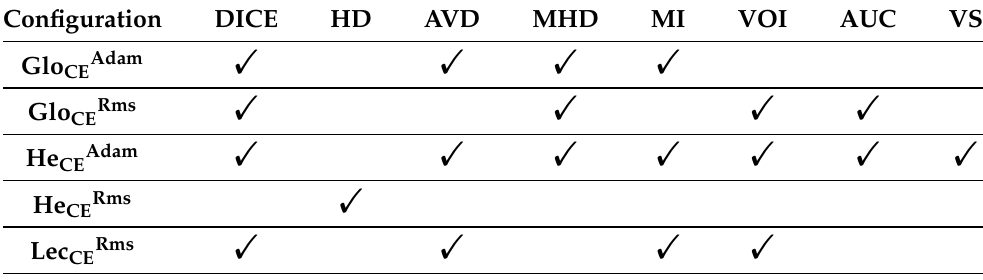
Table 6. Statistical Significant differences ( p ≤ 0.05) denoted by checkmark for each configuration in comparison to Lec Adam for Pancreas Dataset. CE